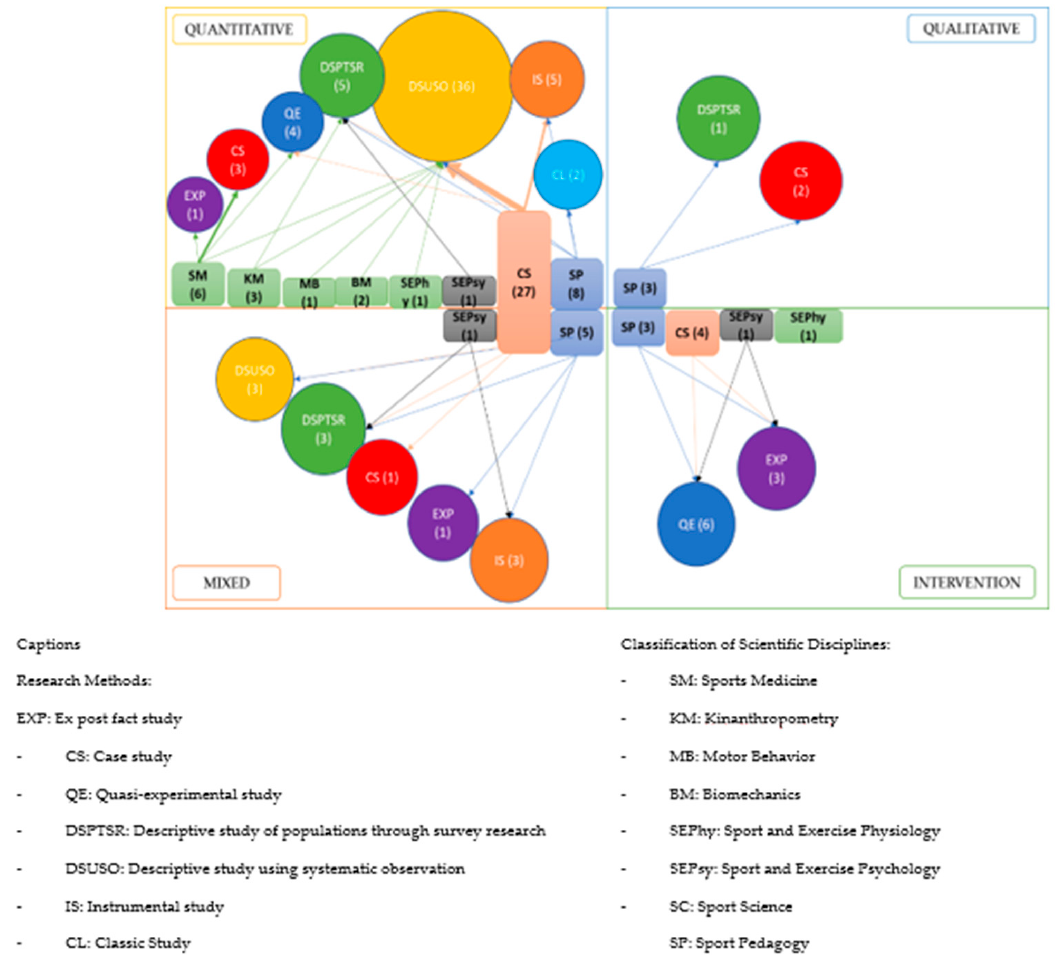
Figure 5. Classification of research in doctoral theses on